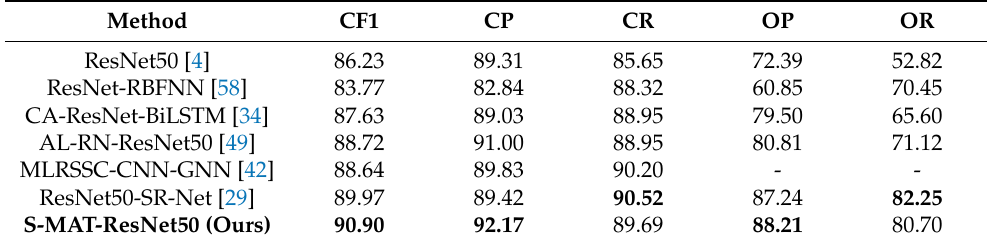
Table 2. Comparisons of our method with previous state-of-the-art methods on the AID Multi-label dataset. Among all the metrics, CF1 is the primary metric. The bold means the best performance. All metrics are in %.